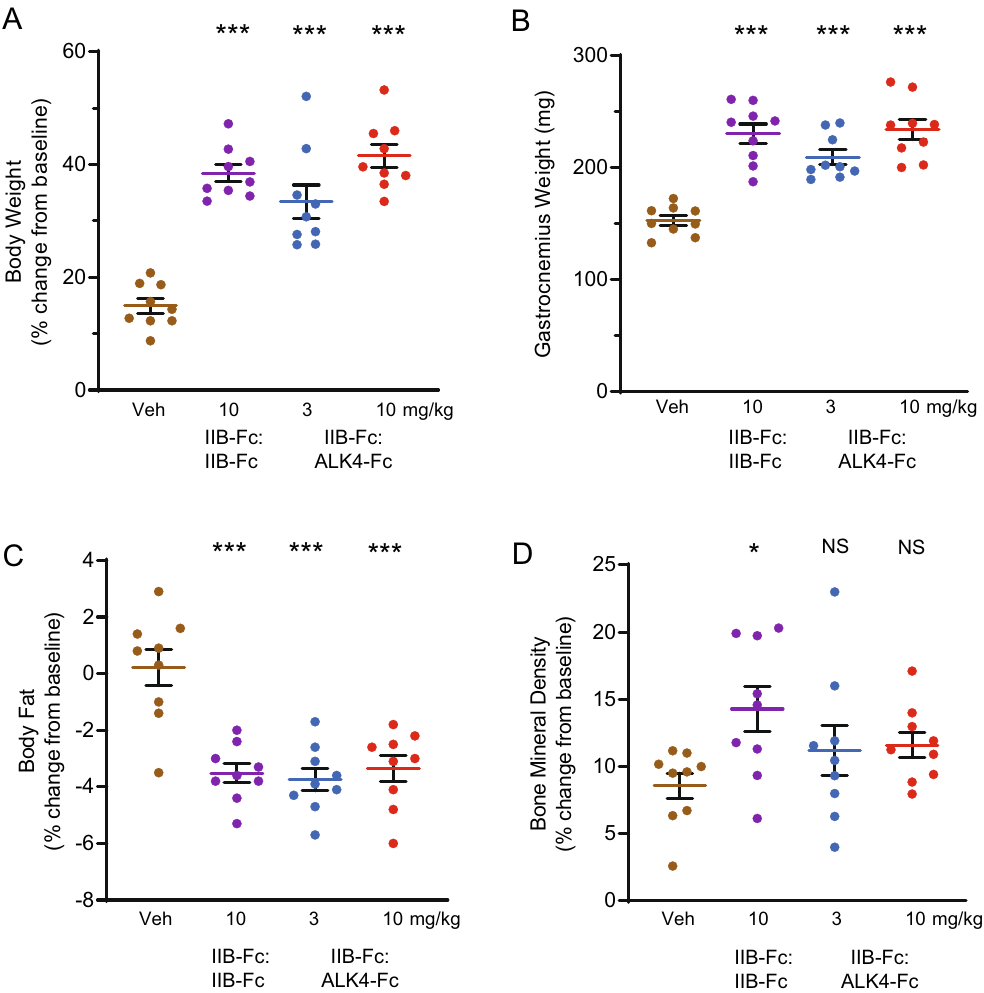
Figure 4. Activity of IIB-Fc:ALK4-Fc heterodimer in wild-type mice. Eight-week-old wild-type C57BL/6 mice ( n = 9 per group) were injected s.c. with IIB-Fc:IIB-Fc (10 mg/kg), IIB-Fc:ALK4-Fc (either 3 mg/kg or 10 mg/ kg), or vehicle control (PBS) twice weekly for 28 days. ( A ) Percentage change in mouse total body weight from day -1 to day 28. ( B ) Weight of the gastrocnemius muscle isolated by dissection on day 28. ( C ) Percentage change in total fat mass normalized to body weight from day -1 to day 27 as assessed by NMR. ( D ) Percentage change in bone mineral density from day -1 to day 27 as assessed by DXA. Data are means ± SEM. See Supplemental Table S2 for associated statistics. Veh vehicle; mg/kg milligrams per kilogram; NS not significant. * P < 0.05, *** P < 0.001 vs.